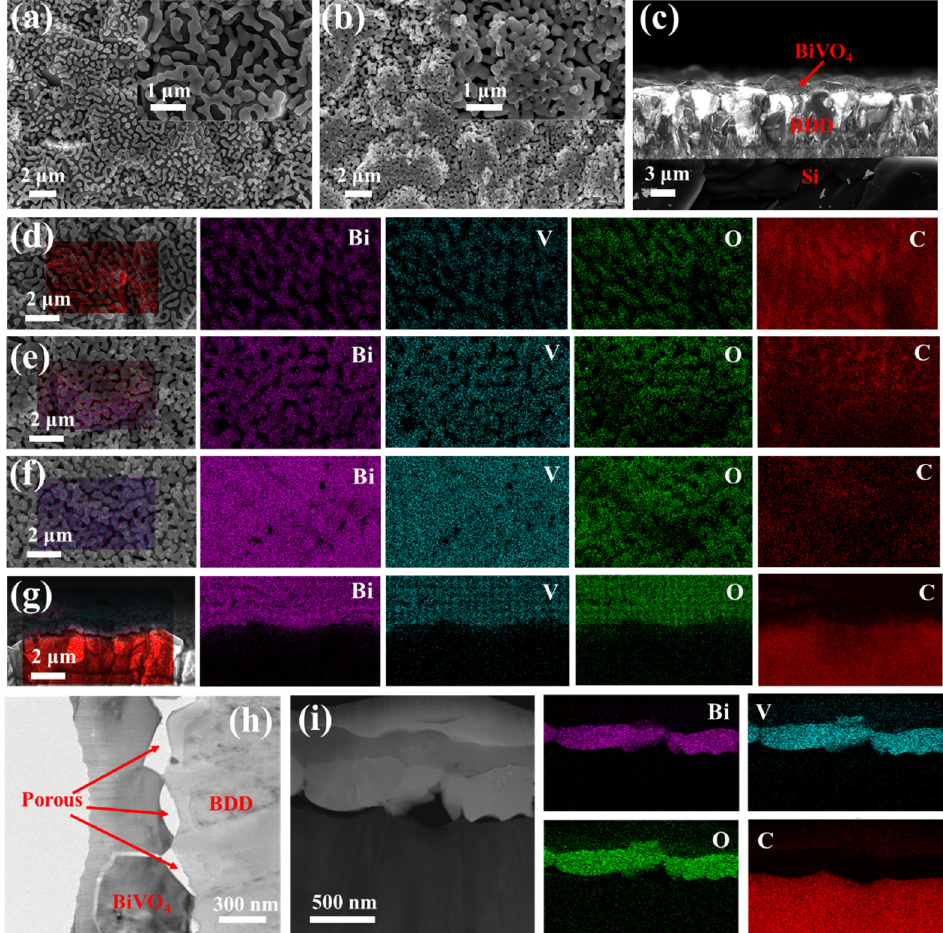
Figure 1. SEM images (top view) and enlarged SEM images (inset) of the BiVO 4 /BDD heterojunction photoanodes for the ( a ) M15 and ( b ) M30; ( c ) SEM image (cross-sectional view) the BiVO 4 /BDD het- erojunction photoanode for the M30; Elemental mapping (top view) the BiVO 4 /BDD heterojunction photoanodes for the ( d ) M15, ( e ) M45, and ( f ) M75; ( g ) Elemental mapping (cross-sectional view) the BiVO 4 /BDD heterojunction photoanode for the M45; ( h ) HRTEM image and ( i ) elemental mapping (enlarged cross-sectional view) of the M30.